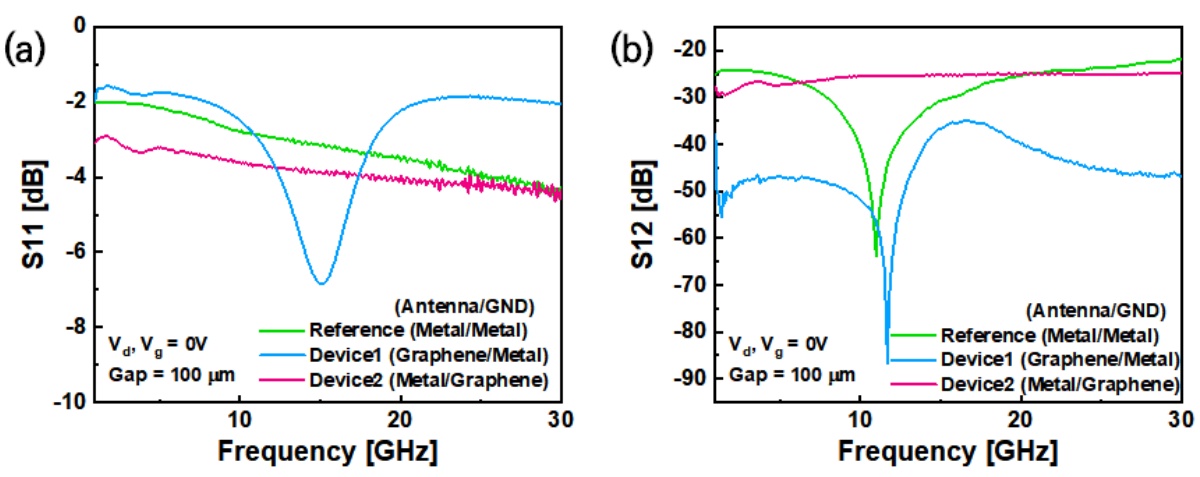
Figure A1. The measured values of Device 1, Device 2, and the reference device, under the same conditions, were compared to analyze the cause of different signal ( a ) reflection and ( b ) transmission characteristics.